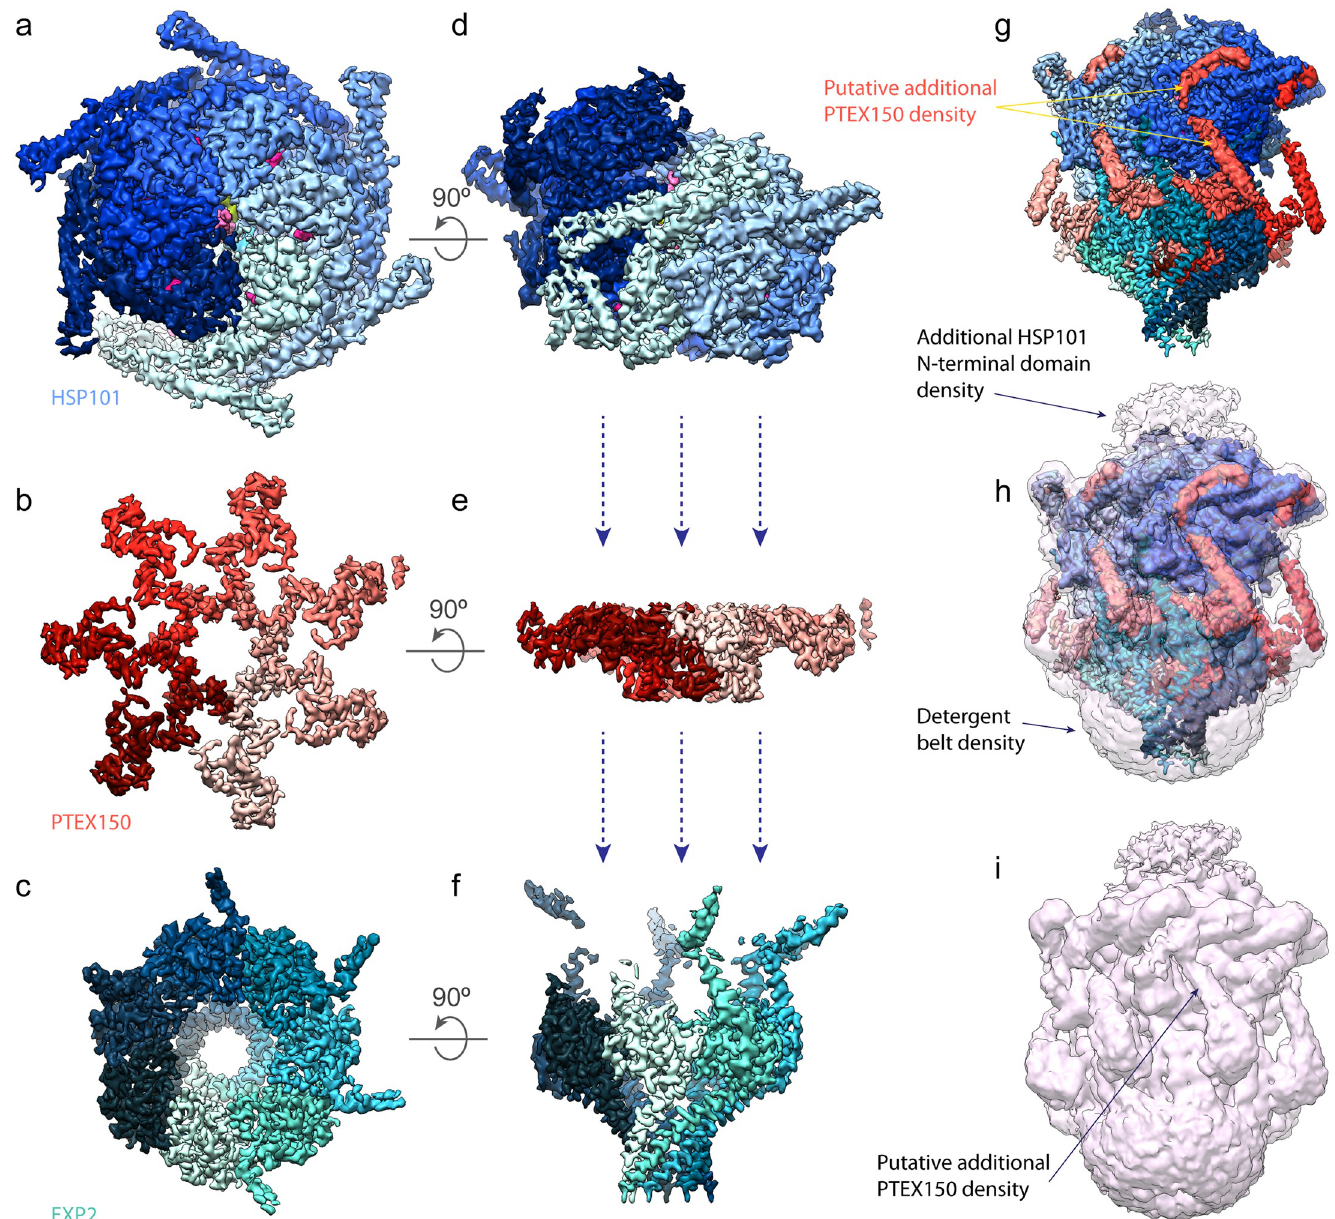
Fig 2. CryoEM structure of PTEX. Top and side views of the HSP101 (a, d), PTEX150 (b, e), and EXP2 (c, f) cryoEM maps are shown. Protomers of each protein are colored as increasingly dark gradients of blue (HSP101), salmon (PTEX150), or aquamarine (EXP2). Also visible in the HSP101 portion of the map are molecules of ATP γ S (magenta) bound to each NBD as well as density corresponding to the polypeptide backbone of cargo within the HSP101 channel (pink). The cargo is engaged by NBD2 pore loops colored light blue (protomers 1–3) and yellow (protomers 4–6). The high-resolution cryoEM map of the full PTEX complex is shown (g), with the same color scheme as in panels (a–f). The same cryoEM map at a lower threshold is shown overlaid with the high-resolution cryoEM map (h) to display additional lower-resolution features, including an additional density above HSP101 which most likely corresponds to the HSP101 NTDs, which are not resolved in the high- resolution structure. Also visible is the detergent belt, as well as long helical densities extending from the PTEX150 (668–823) region. These densities appear to connect to additional densities on top of the HSP101 M-domains. The cryoEM map at a lower threshold is shown alone (i) to allow better visualization of the additional densities. cryoEM, cryo-electron microscopy; EXP2, exported protein 2; HSP101, heat shock protein 101; M-domains, Middle domains; NBD, nucleotide-binding domain; NTD, N-terminal domain; PTEX, Plasmodium Translocon of EXported proteins.